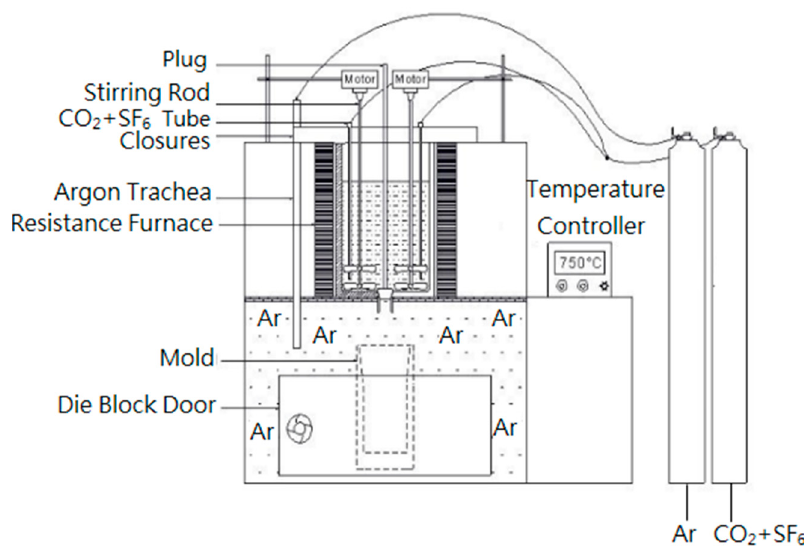
Figure 1. Schematic of the stir-casting melting furnace.